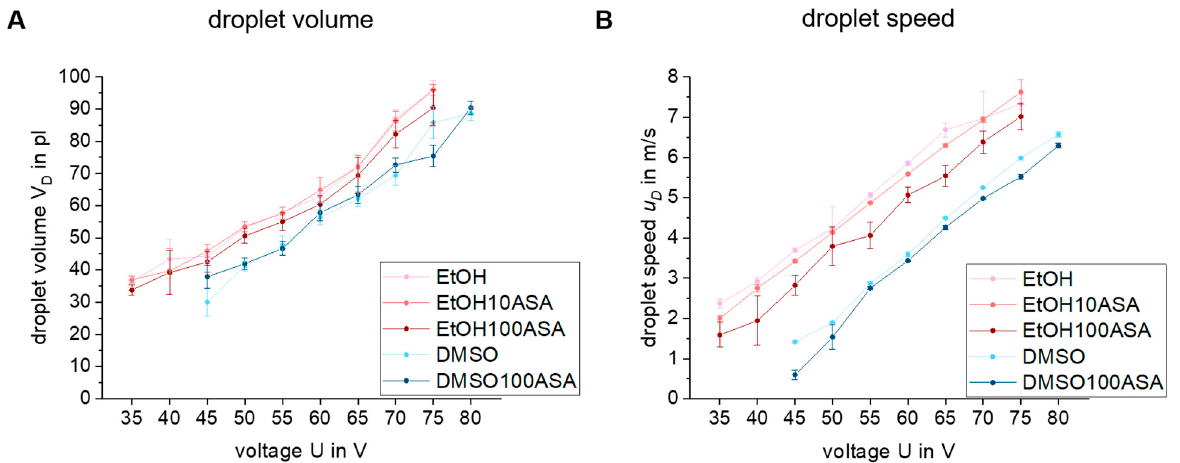
Figure 4. Plots of the droplet volume V D ( A ) and droplet speed u D ( B ) over voltage of the printhead of all investigated drug solutions as well as the pure solvents. Drug solutions and pure solvents show similar averages and standard deviations. There is a little decrease of V D and u D of EtOH100ASA as a result of the increase of viscosity by drug solving. The plots show means ± standard deviations for n = 10.